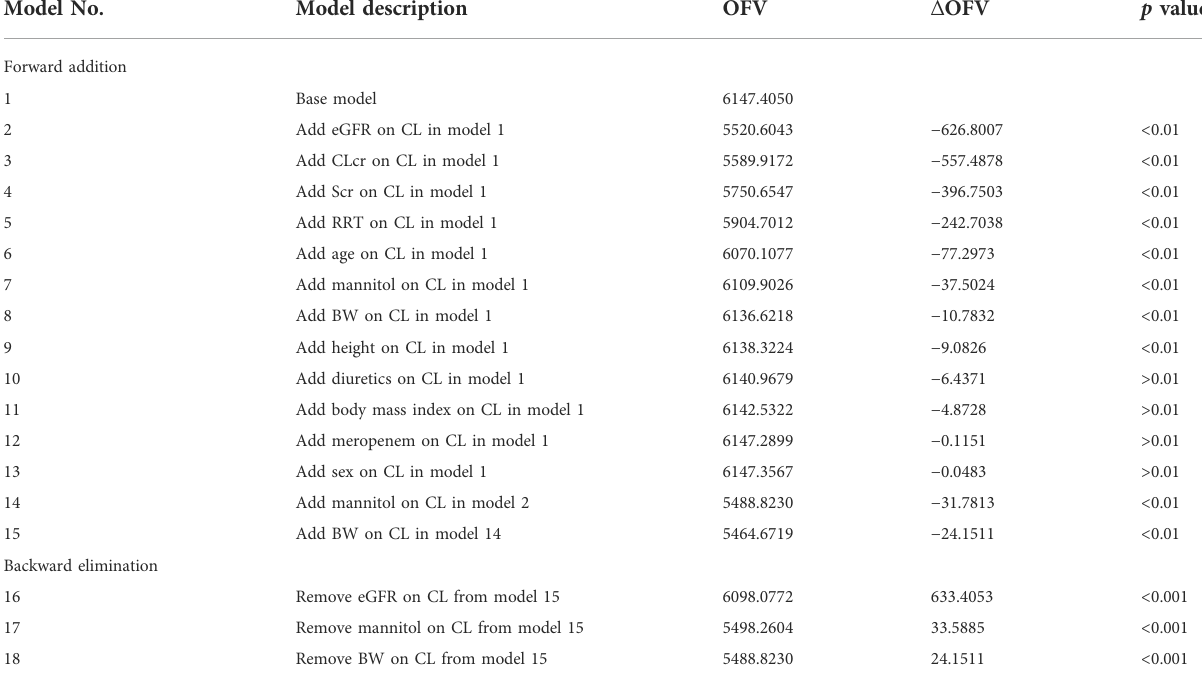
TABLE 2 Results in the model development procedure of vancomycin population pharmacokinetic model. Model No.